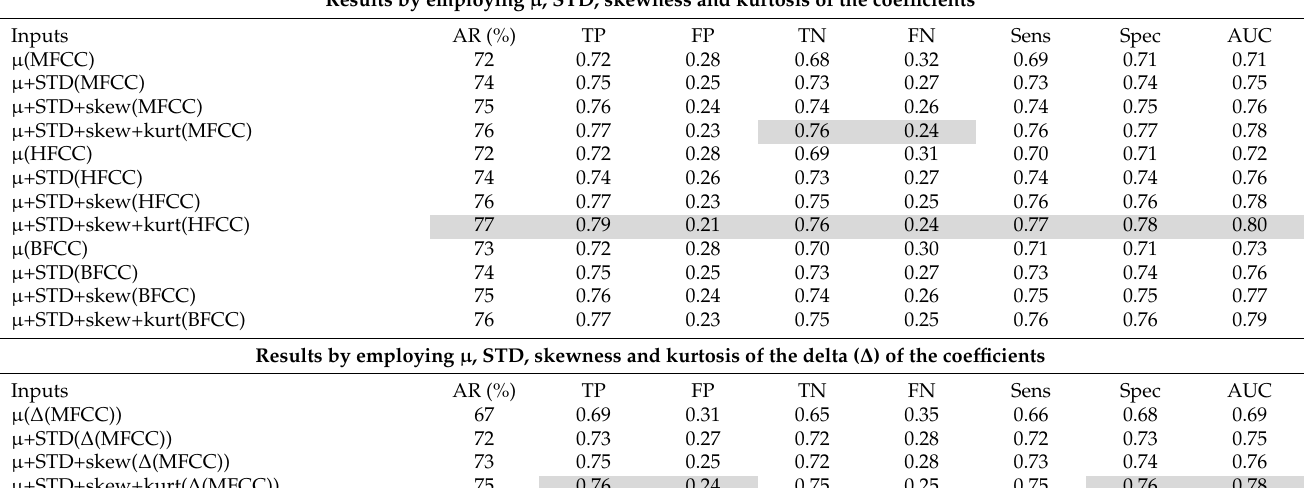
Table 3. Evaluation of the RF model with MFCC, HFCC and BFCC filters, by incrementally employing the first four moments of their distributions (mean- µ , standard deviation-STD, skewness-skew and kurtosis-kurt), their ∆ and their ∆∆ . 10-cross-validation with 20,000 laughs (18,000 training and 2000 test in 10 epochs). AR, accuracy rate; TP, true positive; FP, false positive; TN, true negative; FN, false negative; Sens, sensitivity; Spec, specificity. Best performance per column is highlighted in bold. Results by employing µ , STD, skewness and kurtosis of the